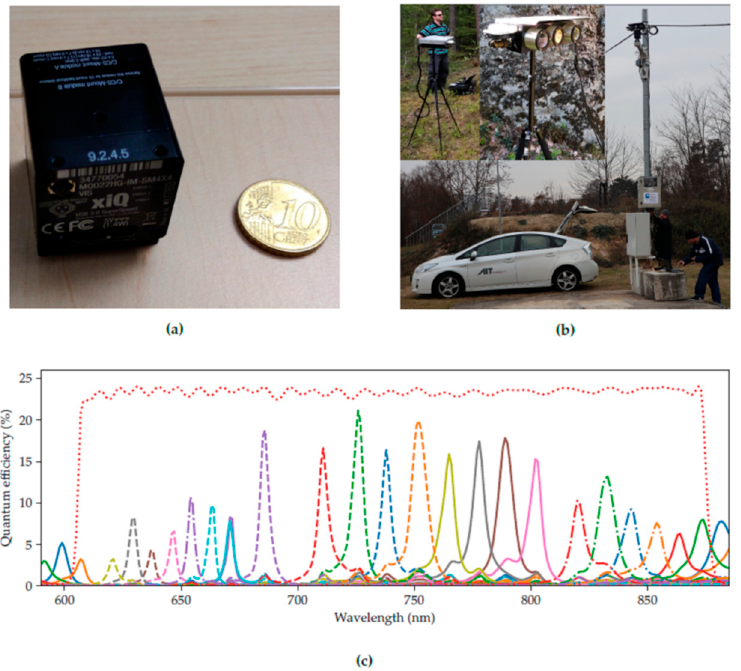
Figure 1. The camera system. ( a ) XIMEA MQ022HG-IM-SM5X5-NIR camera compared to a EUR 0.10 coin. ( b ) Camera system on a tripod and on a mast (top left). ( c ) Response curves of the camera (The red dotted line is the combined transfer function of the optical filters). Taken from [5].